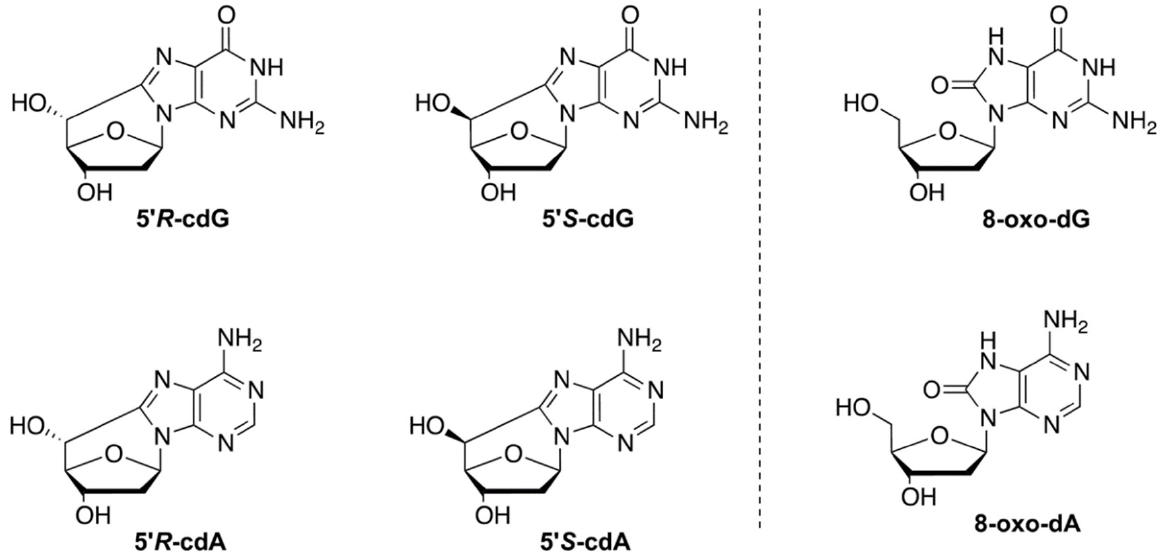
Figure 1. Structures of 5 ′ ,8-cyclo-2 ′ -deoxyguanosine (cdG) and 5 ′ ,8-cyclo-2 ′ -deoxyadenosine (cdA) in their 5 ′ R and 5 ′ S diastereomeric forms ( left ) and 8-oxo-7,8-dihydro-2 ′ -deoxyguanosine (8-oxo-dG) and 8-oxo-7,8-dihydro-2 ′ -deoxyadenosine (8-oxo-dA) ( right ).